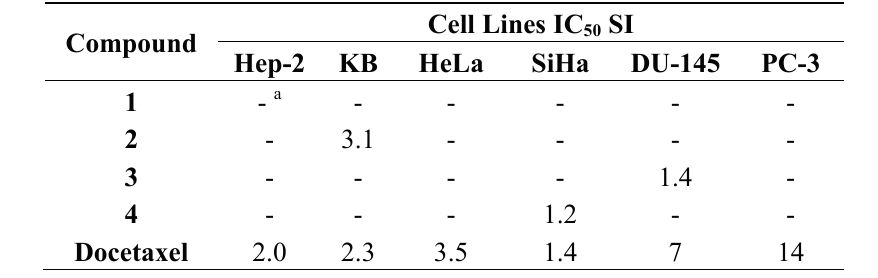
Table 5. Selectivity index (SI) of antiproliferative activity of compounds isolated from A. fascicularis root